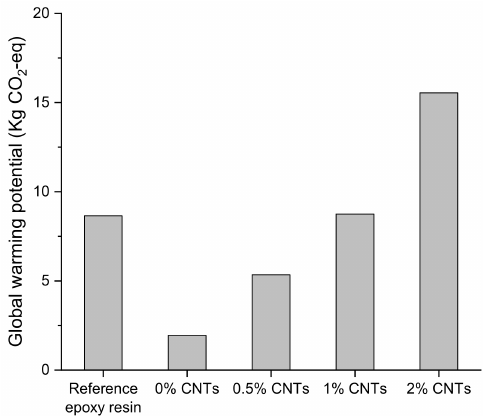
Figure 7. Comparison of the GWP between the neat, the nano-filled bio-based adhesive and the reference epoxy in terms of CO 2 emissions.